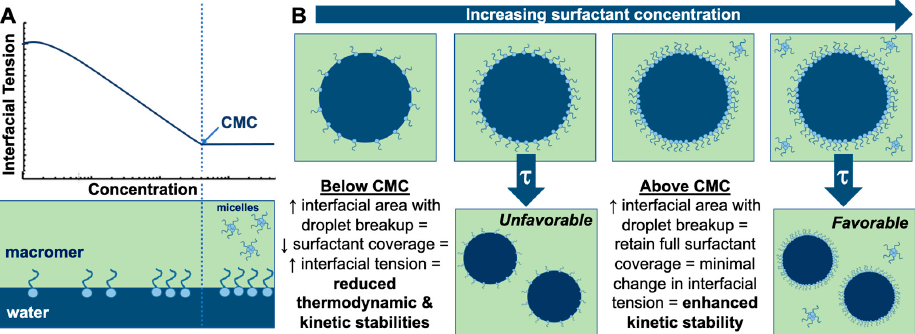
Figure 4. Overview of the role of surfactant concentration on droplet size in HIPEs. ( A ) Schematic representation of the decrease in interfacial tension with increasing surfactant adsorption at the interface until the CMC, after which interfacial tension is constant. ( B ) Schematic of the role of surfactant concentration on droplet breakup during emulsification above and below the CMC.